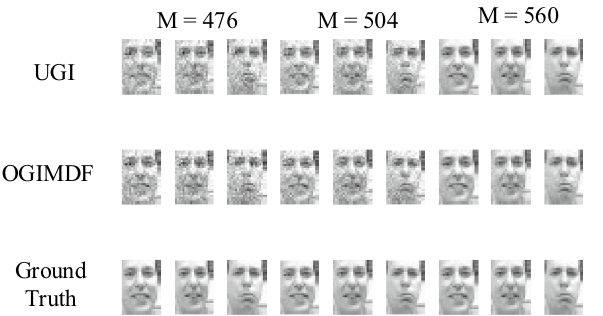
Figure 6. Reconstruction results of grayscale targets under different sampling numbers for UGI and OGIMDF schemes. M represents the sampling